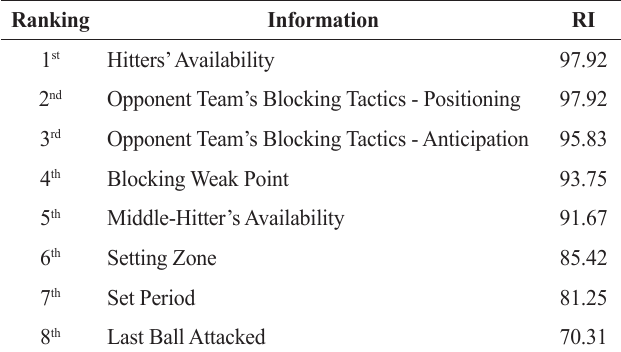
Table 2: Classification of information contained in the Attack Pro- cesses based on their Response Index.